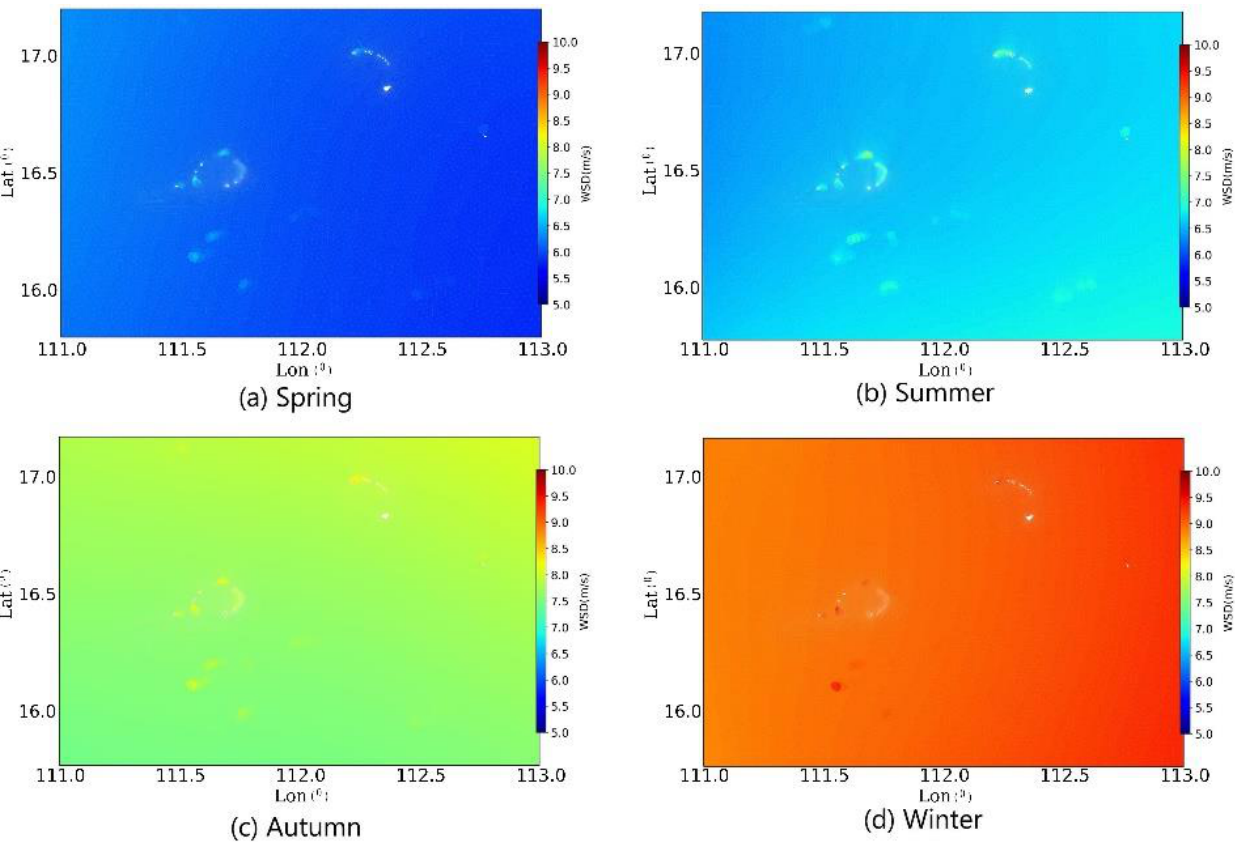
Figure 7. Seasonal distribution of hourly averaged wind speed (WSD) in the Xisha Islands.